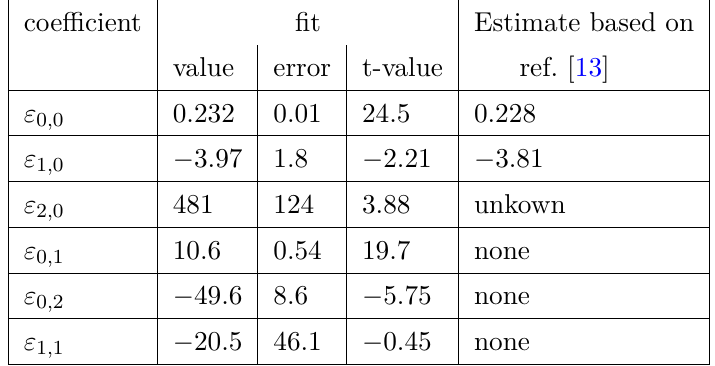
Table 2 . Simultaneous large- N and continuum fit for T = 0 . 3 , µ = 0 . 5 with ansatz (5.2). Residual standard error: 0.986 on 40 degrees of freedom. Data includes unconstrained simulations at N ≥ 10